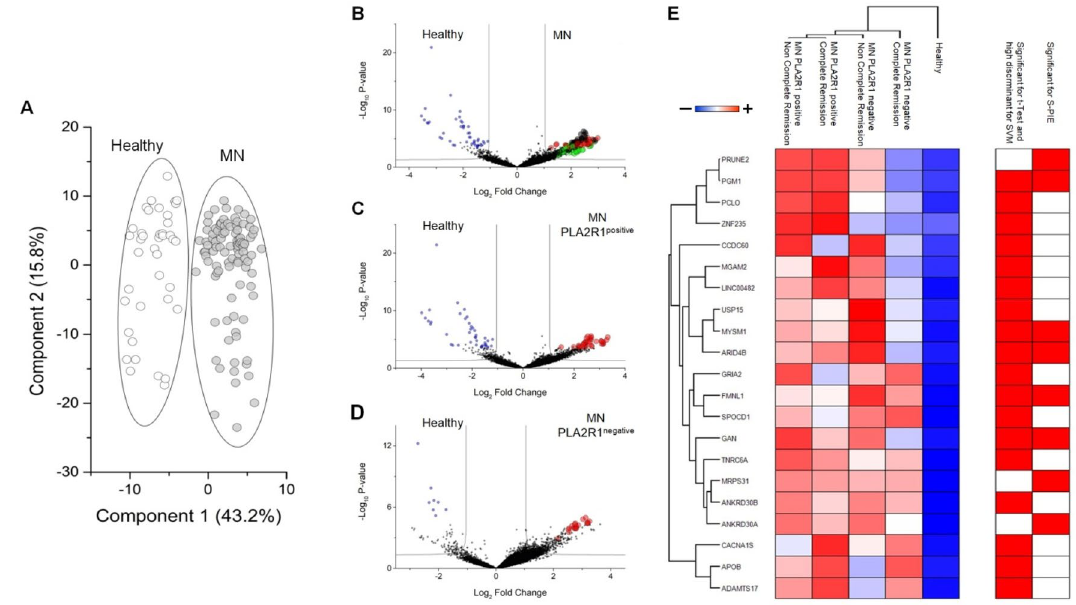
Figure 2. Validation Peptides array. ( A ) Scatter plot of Multidimensional Scaling (MDS) analysis of validation peptide intensity profiles of healthy (open circles) and MN (grey circles) patients. Symbols and ellipses indicate respectively each sample and the 95% confidence interval of the two conditions. Visual inspection of the scatter plot demonstrates the ability of their intensity value to clearly discriminate between the healthy and MN patient conditions. ( B–D ) Volcano plot of statistically significant peptides in the comparison between healthy and all MN patients ( B ) or healthy and MN anti-PLA2R1 positive ( C ) or healthy and MN anti-PLA2R1 negative ( D ). Small Black, blue, red, green and large black circles show respectively not statistically significant peptides, statistically up-regulated in healthy or in MN patients (positive or negative for anti-PLA2R1), selected from S-PIE, WGCNA and t-test analyses. The black line shows the cut-off of statistical significance. ( E ) Heatmap of 21 core proteins identified through the combined use of WGCNA, univariate statistical analysis, support vector machine learning and S-PIE analysis. In the heatmap, each row represents a protein and each column corresponds to a clinical condition. Normalized Z-scores of protein abundance are depicted by a pseudocolor scale with red indicating positive expression, white equal expression and blue negative expression compared to each protein value, whereas the dendrogram (on the top and left) displays the outcome of unsupervised hierarchical clustering analysis, placing similar sample/proteome profile values near each other. Visual inspection of the dendrogram and heat map demonstrates the ability of these proteins to clear discriminate between the different